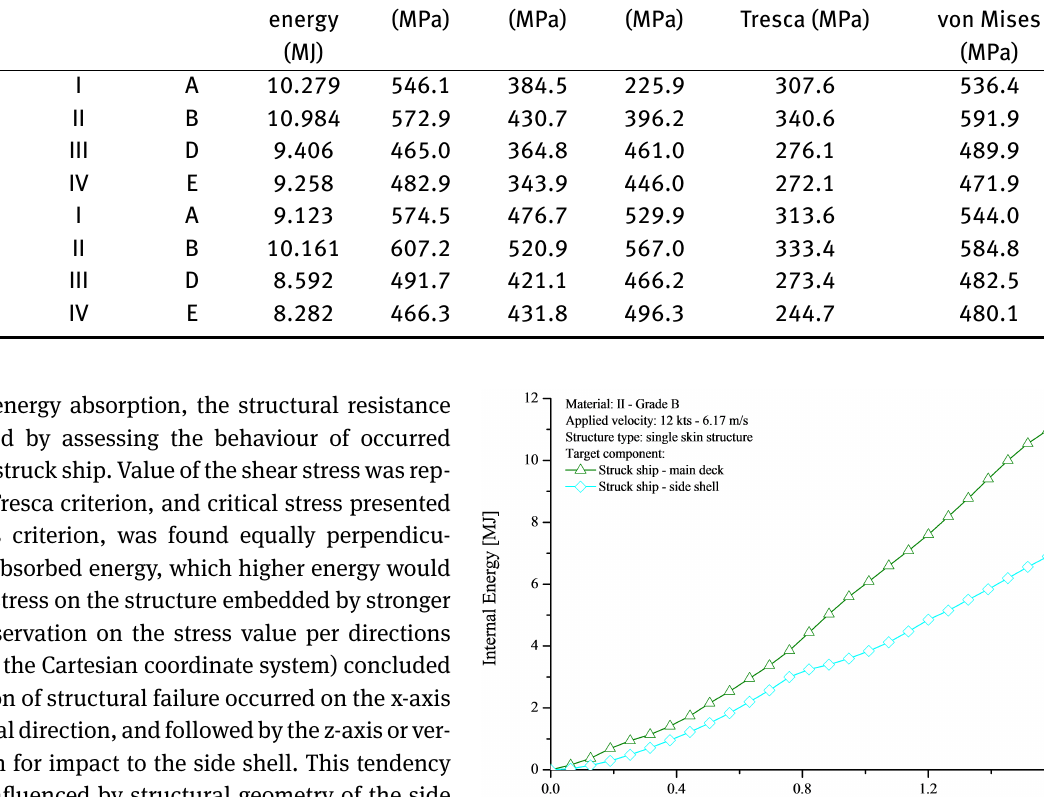
Table 5: Energy absorption and structural responses after side impact on the main deck. Structure